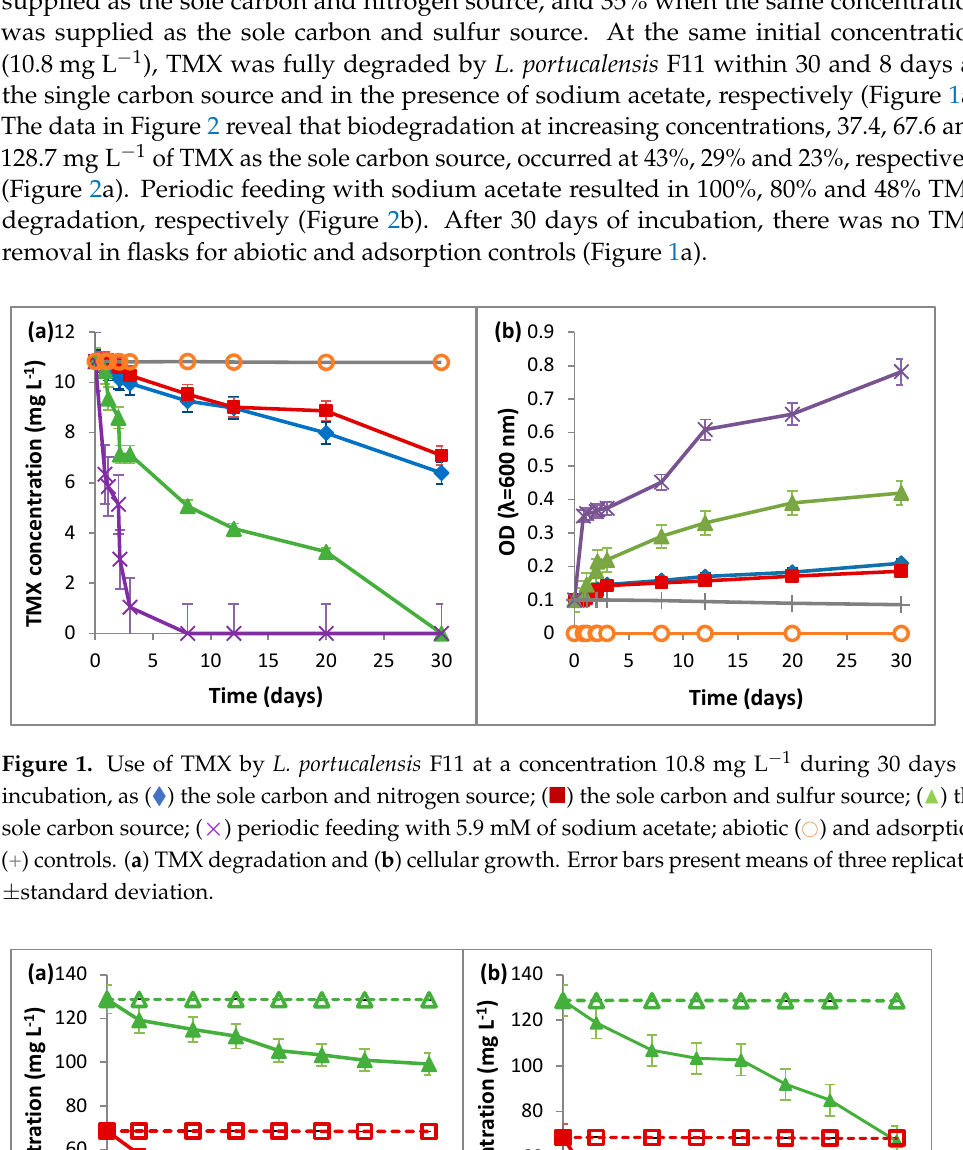
Figure 2. Biodegradation of TMX by L. portucalensis F11 at concentrations: 37.4 mg L − 1 ( ♦ ), 68.6 mg L − 1 ( ■ ) and 128.7 mg L − 1 ( ▲ ), and respective abiotic controls ( ◊ , ⸋ , Δ ), during 30 days of incubation, ( a ) as the sole carbon source and ( b ) with periodic feeding with sodium acetate (5.9 mM). Error bars present means of three replicates ± standard deviation.